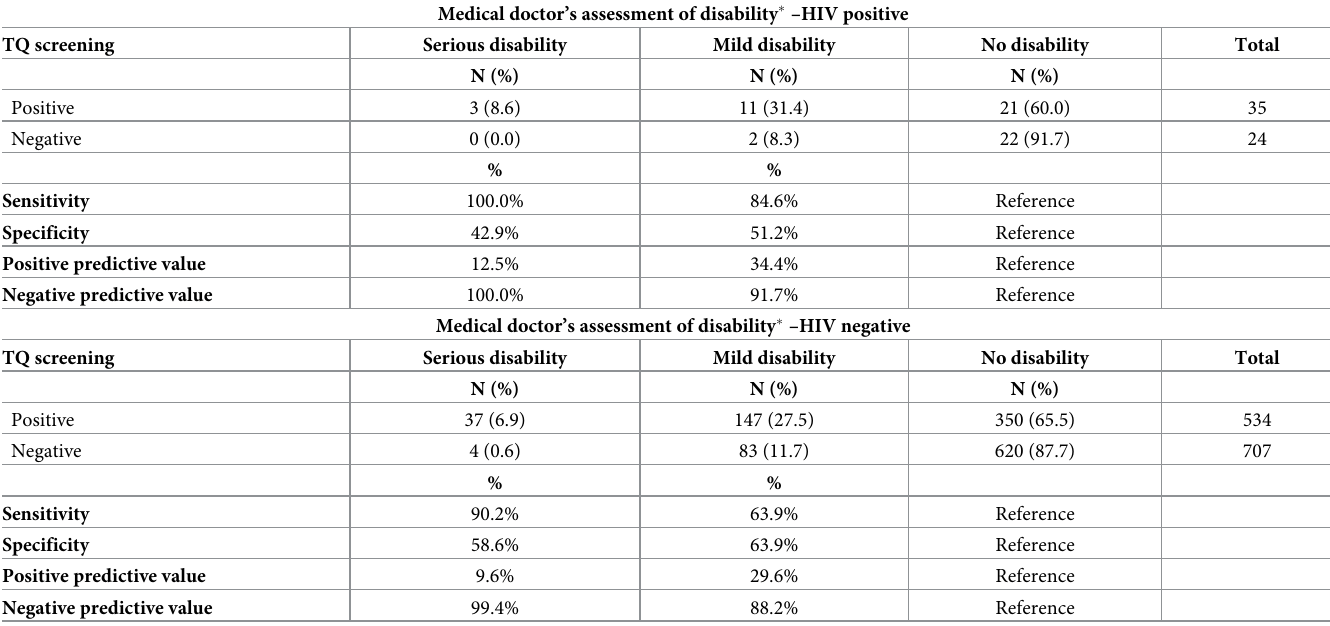
Table 5. Results of medical doctor disability assessment for children screened by TQ. Medical doctor’s assessment of disability (cid:3) –HIV